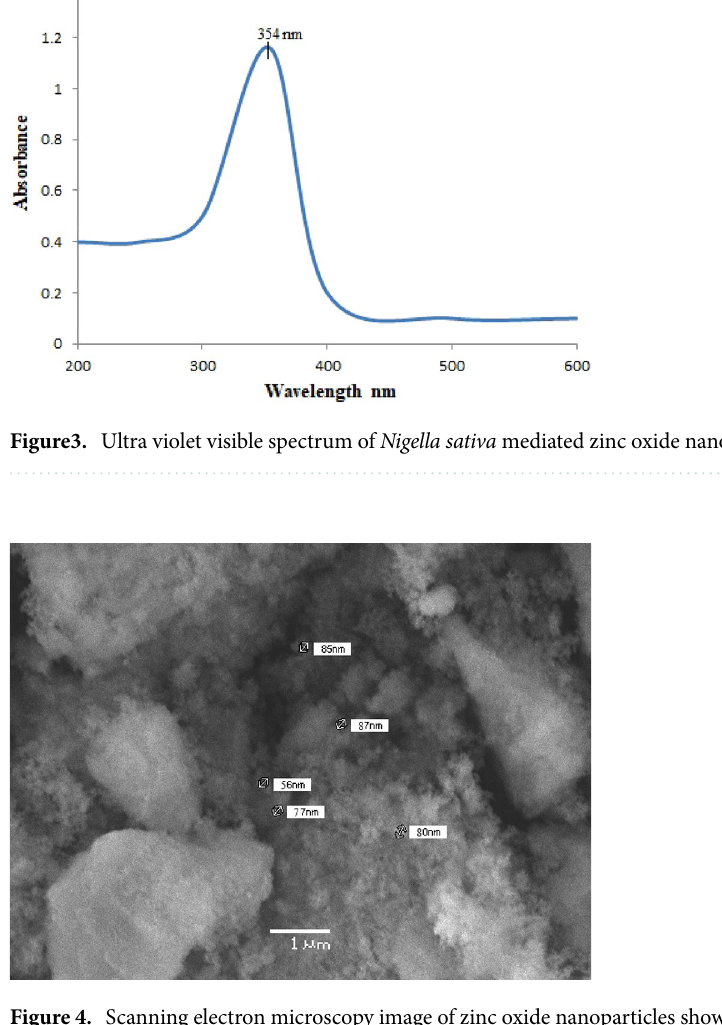
Figure 4. Scanning electron microscopy image of zinc oxide nanoparticles showing diameter at 1 µm